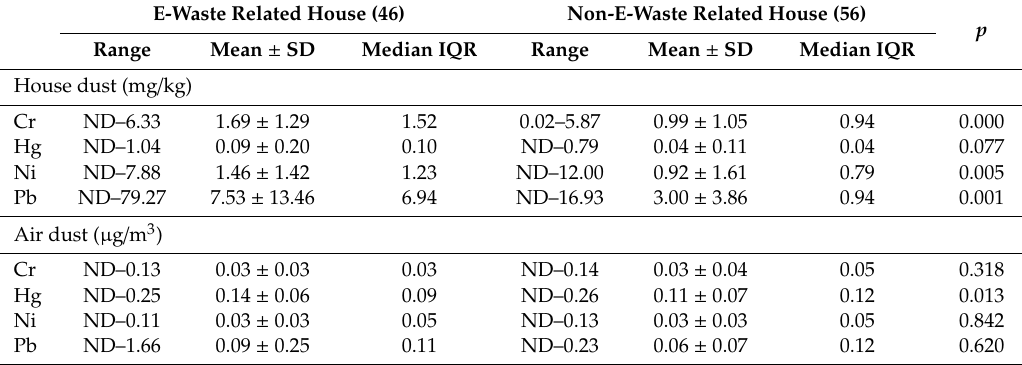
Table 2. Heavy metal concentrations in house dust and airborne dust collected from study participants.